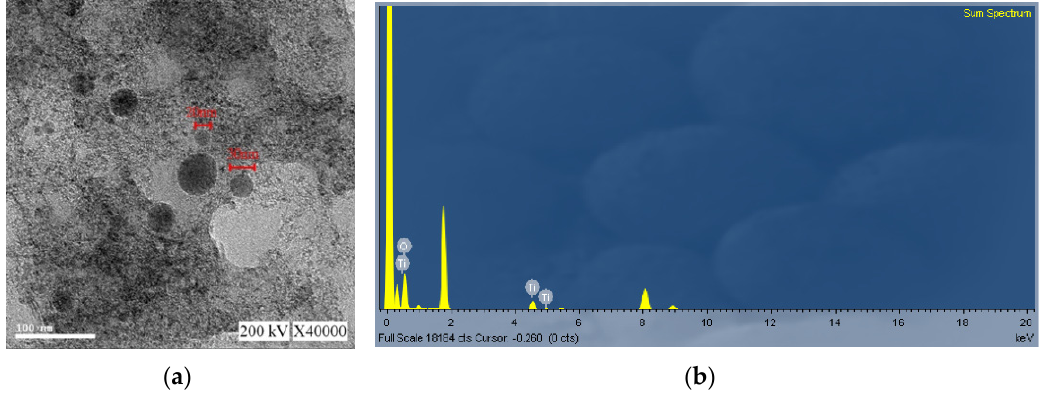
Figure 14. Analysis of C40-40-100 min colloids: ( a ) enlarged TEM image at 40,000 × magnification; ( b ) EDS composition analysis.